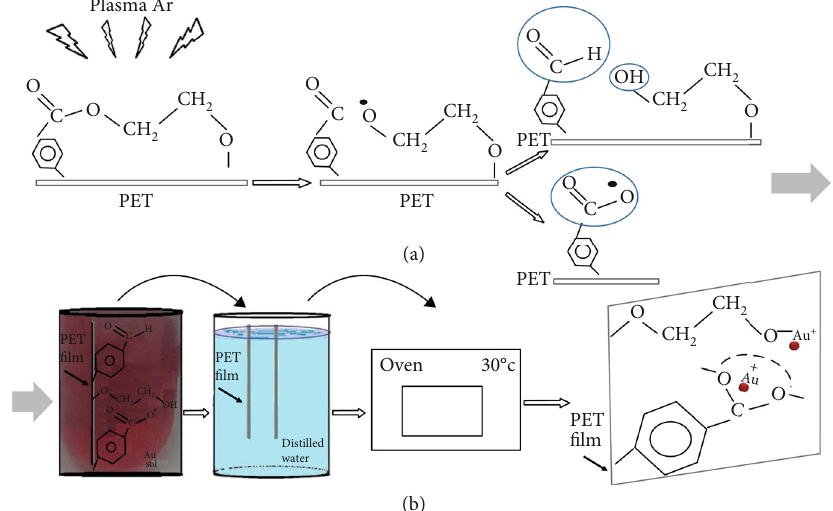
Figure 1: Schematic treatment